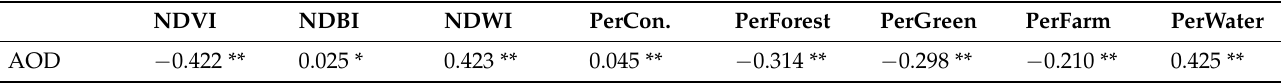
Table 3. Correlation coefficients between AOD (Aerosol Optical Depth) and LULC (Land use/Land cover) -related variables.